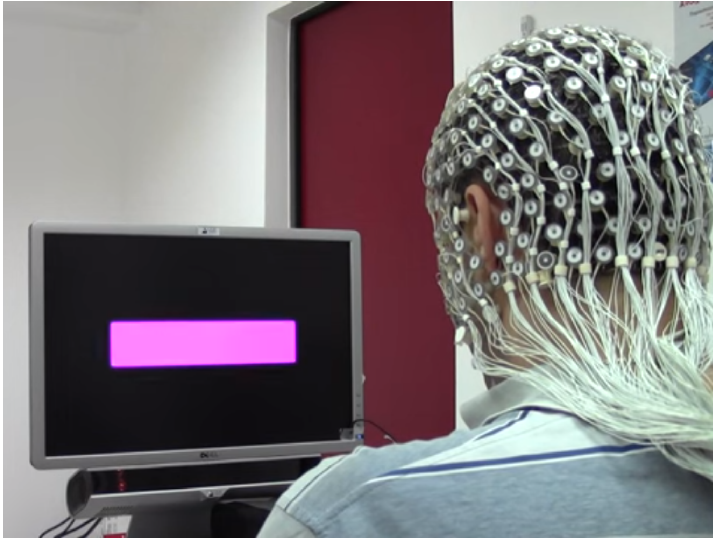
Figure 5. Experimental setup for the acquisition of EEG SSVEP data. Image taken from https://youtu. be/8lGBVvCX5d8 (accessed on 2 February